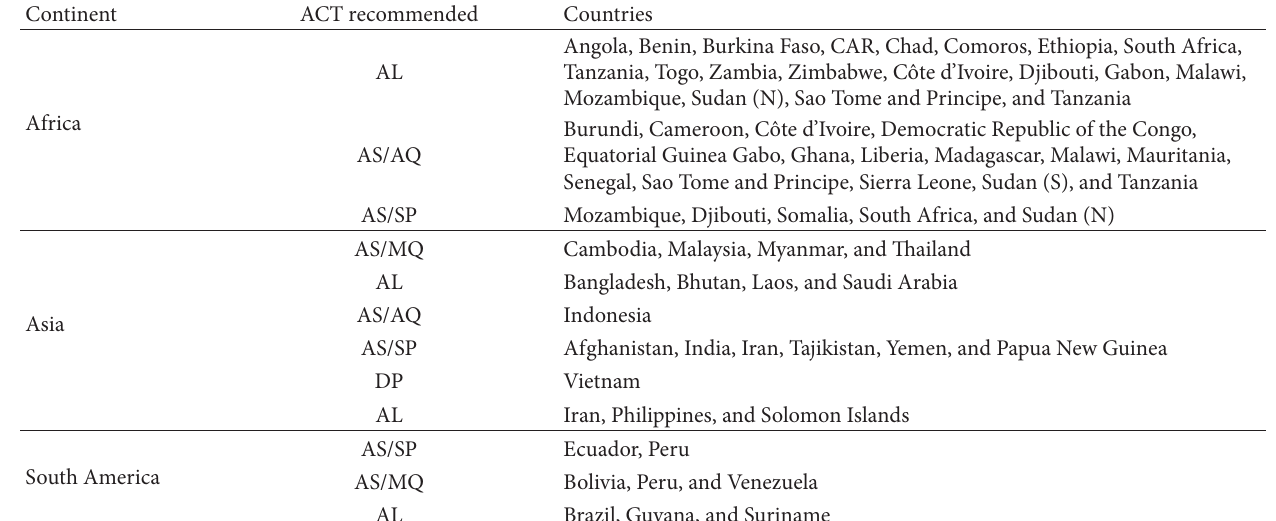
Table 3: ACT recommended in different countries